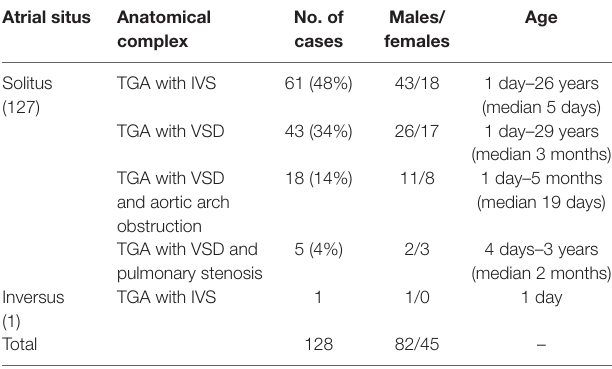
TaBle 2 | complete